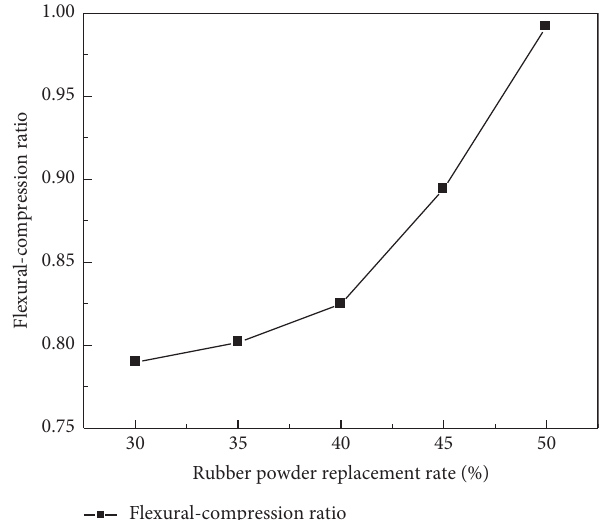
Figure 7: Relationship between rubber powder replacement rate and flexural-compression ratio of